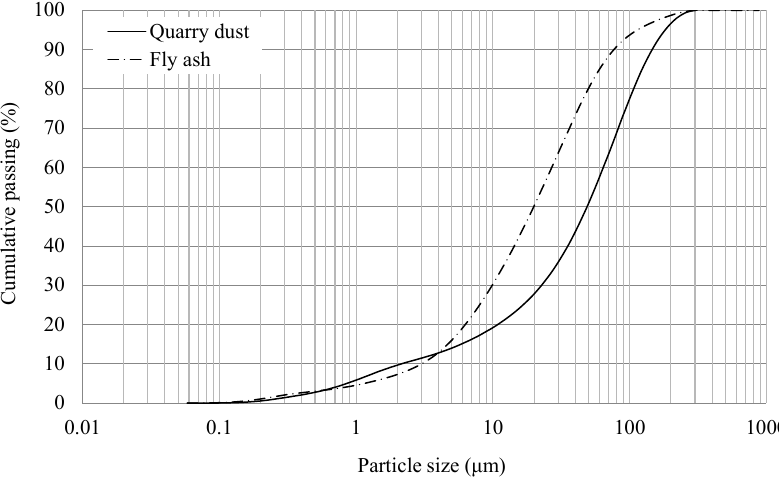
Figure 3. Particle size distribution of quarry dust and fly ash used.